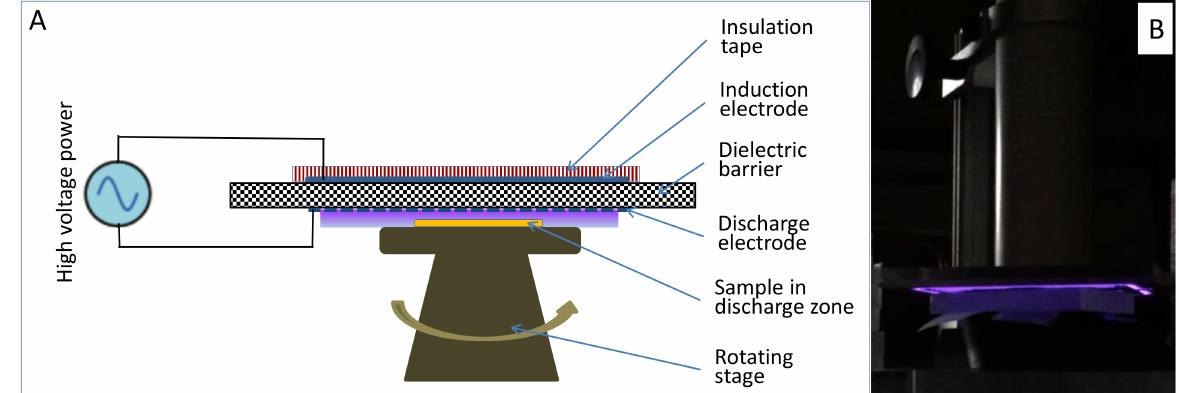
Figure 1. ( A ) Diagram of the NTP system and ( B ) photo showing a sample under glowing plasma